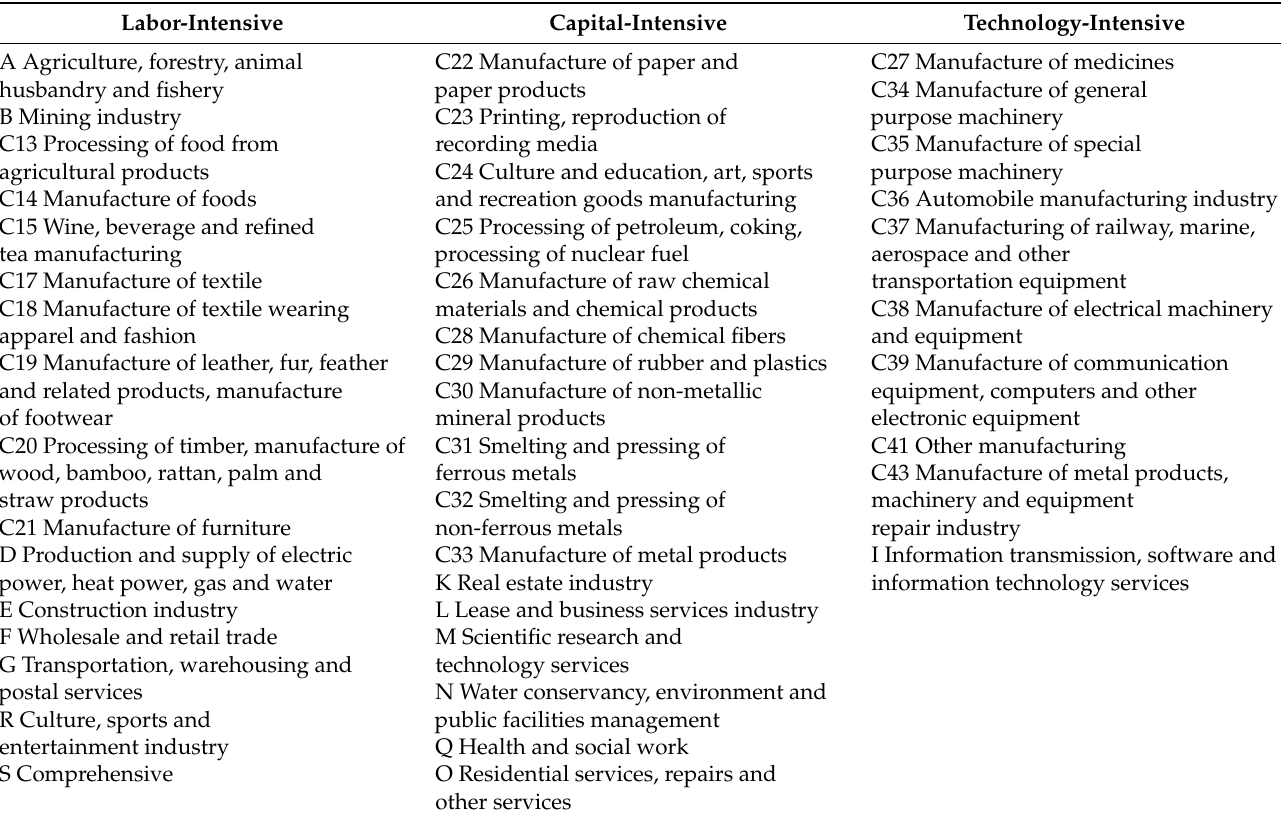
Table 2. Industry classifications by factor